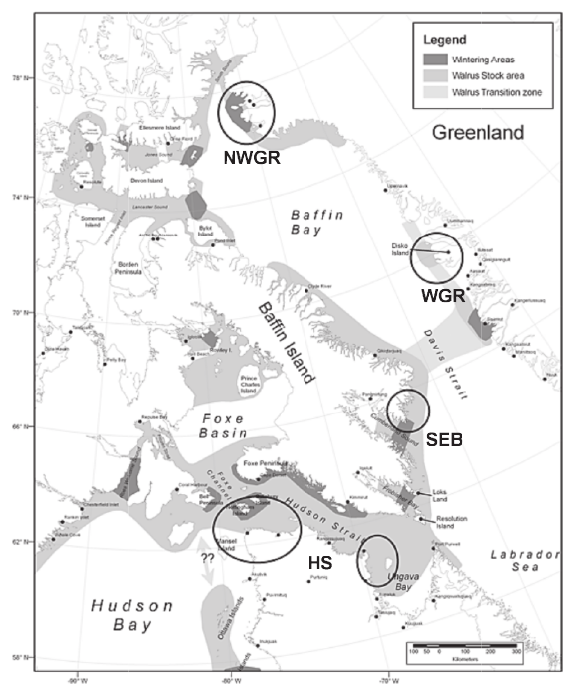
Fig. 1. Distribution of Atlantic wal- ruses in western Greenland and east- ern Canada with indications of puta- tive stocks following Born et al. (1995), Stewart (2008), Andersen et al. (2009). General sampling areas are indicated (NWGR=Northwest Greenland, WGR=West Greenland, SEB=Southeast Baffin Island, HS=Hudson Strait), sample sizes and acronyms see Tables 1 and 2. (Dark grey shaded area=wintering areas, medium grey shaded area=walrus stock area, light grey shaded area=supposed transition